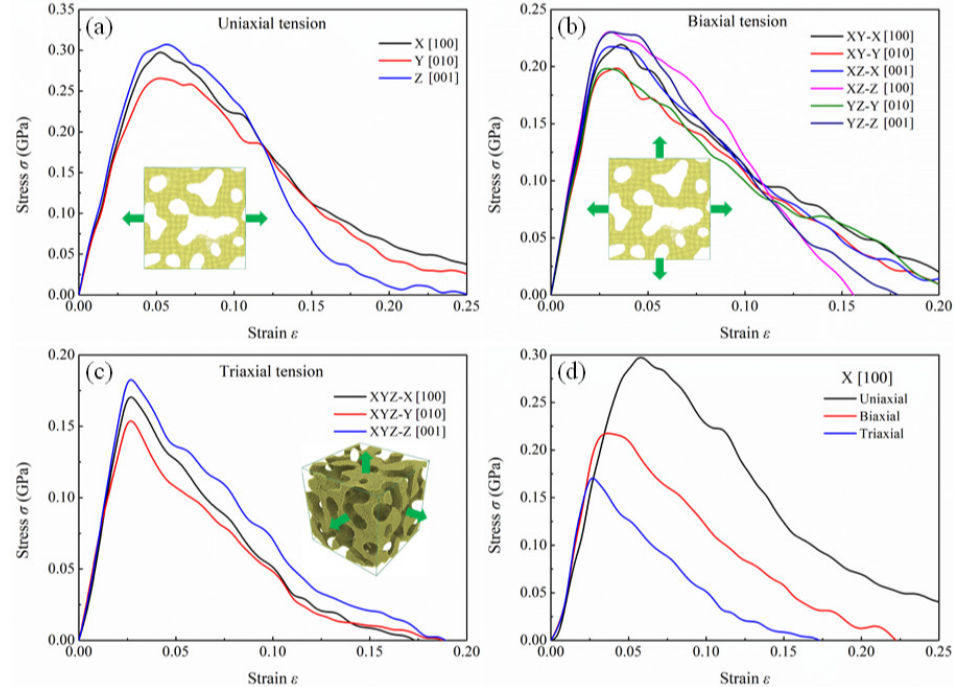
Figure 2. Engineering stress–strain curves of NPG in ( a ) uniaxial tension, ( b ) biaxial tension, and ( c ) triaxial tension. ( d ) Comparison of stress–strain curves of NPG along the X [100] direction under different loading conditions.